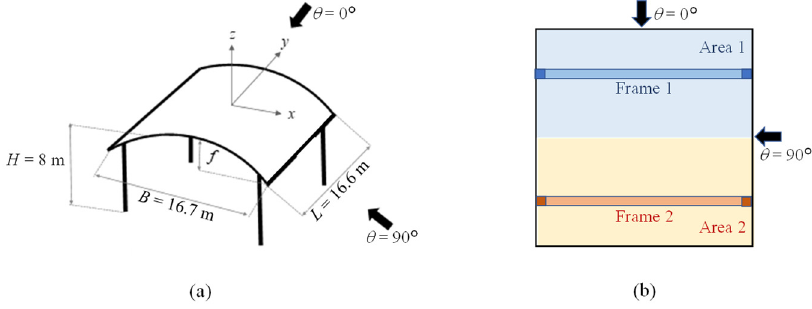
Figure 2. Investigated building: ( a ) General view; ( b ) structural system.